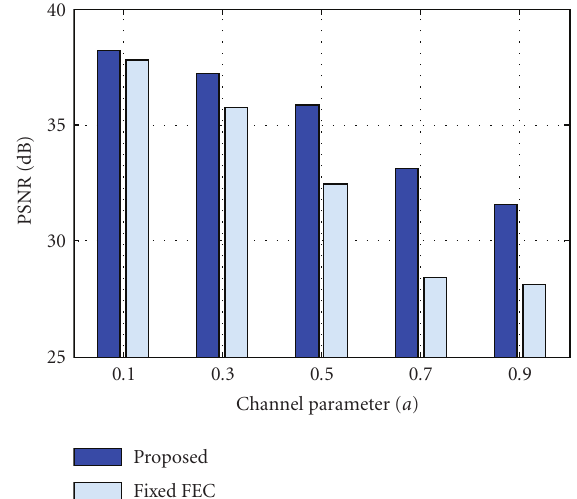
Figure 9: Proportion of packets missing frame display deadlines according to error correction scheme.